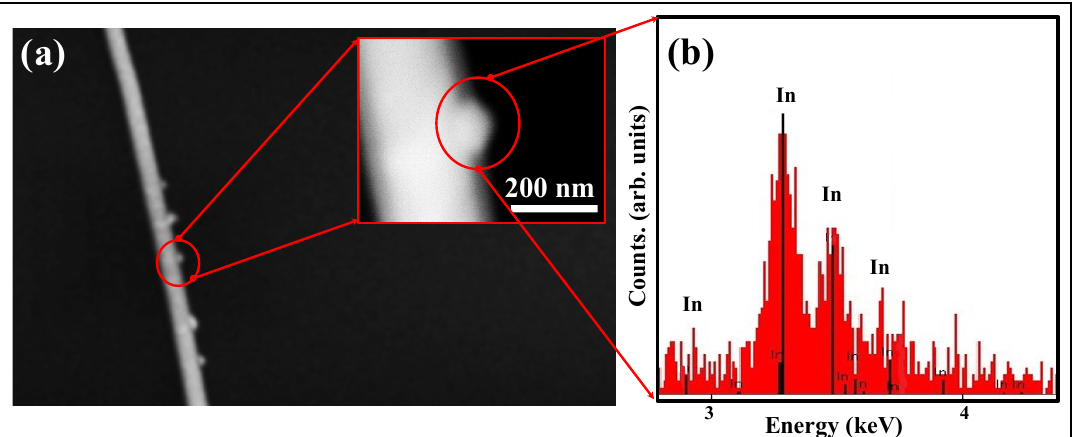
Figure 4. ( a ) SEM image of a single InSb NW grown at 560 ◦ C. Some defects are visible along the NW length and nodules are present along the NW edges. Inset shows a magnified view of the nodule grown along the NW edge; ( b ) EDX spectrum showing that the nodule is pure